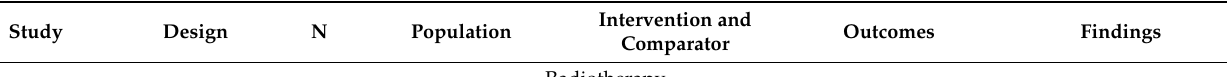
Table 1. Phase III randomized controlled trials (RCT) evaluating neoadjuvant therapy approaches for retroperitoneal sarcoma (RPS)